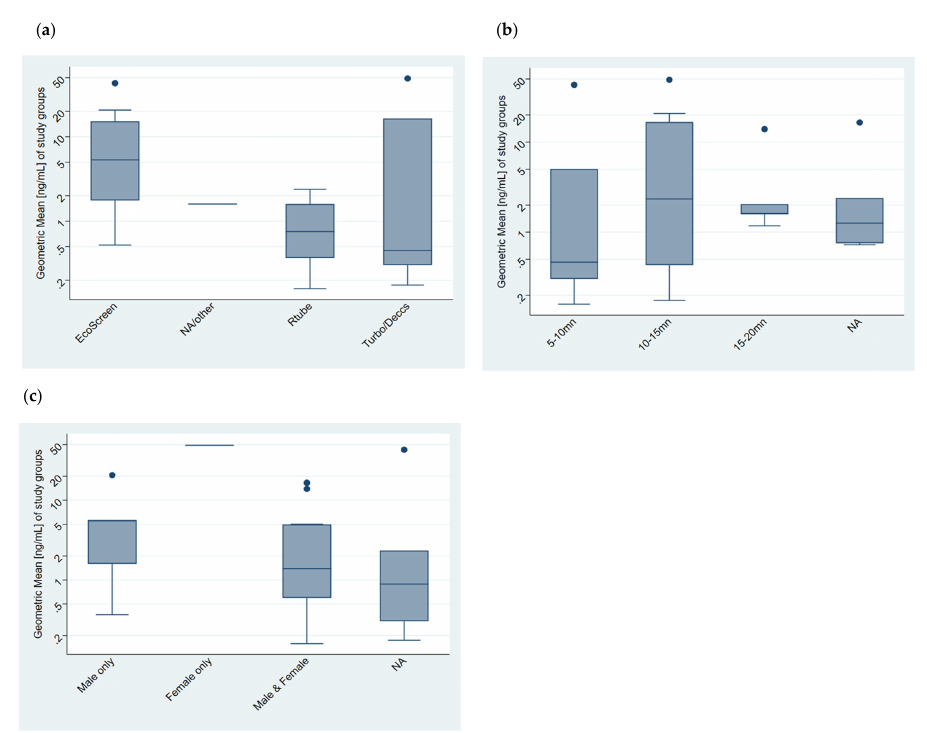
Figure 2. MDA concentration in EBC stratified according to: ( a ) Collection device; ( b ) duration of collection (minutes); ( c ) gender group (no papers with females only). All presented results exclude the outliers and units of the GMs are ng/mL. Table 2. Mixed effects regression analysis according to analytical method, use of nose clip, smoking status, and age